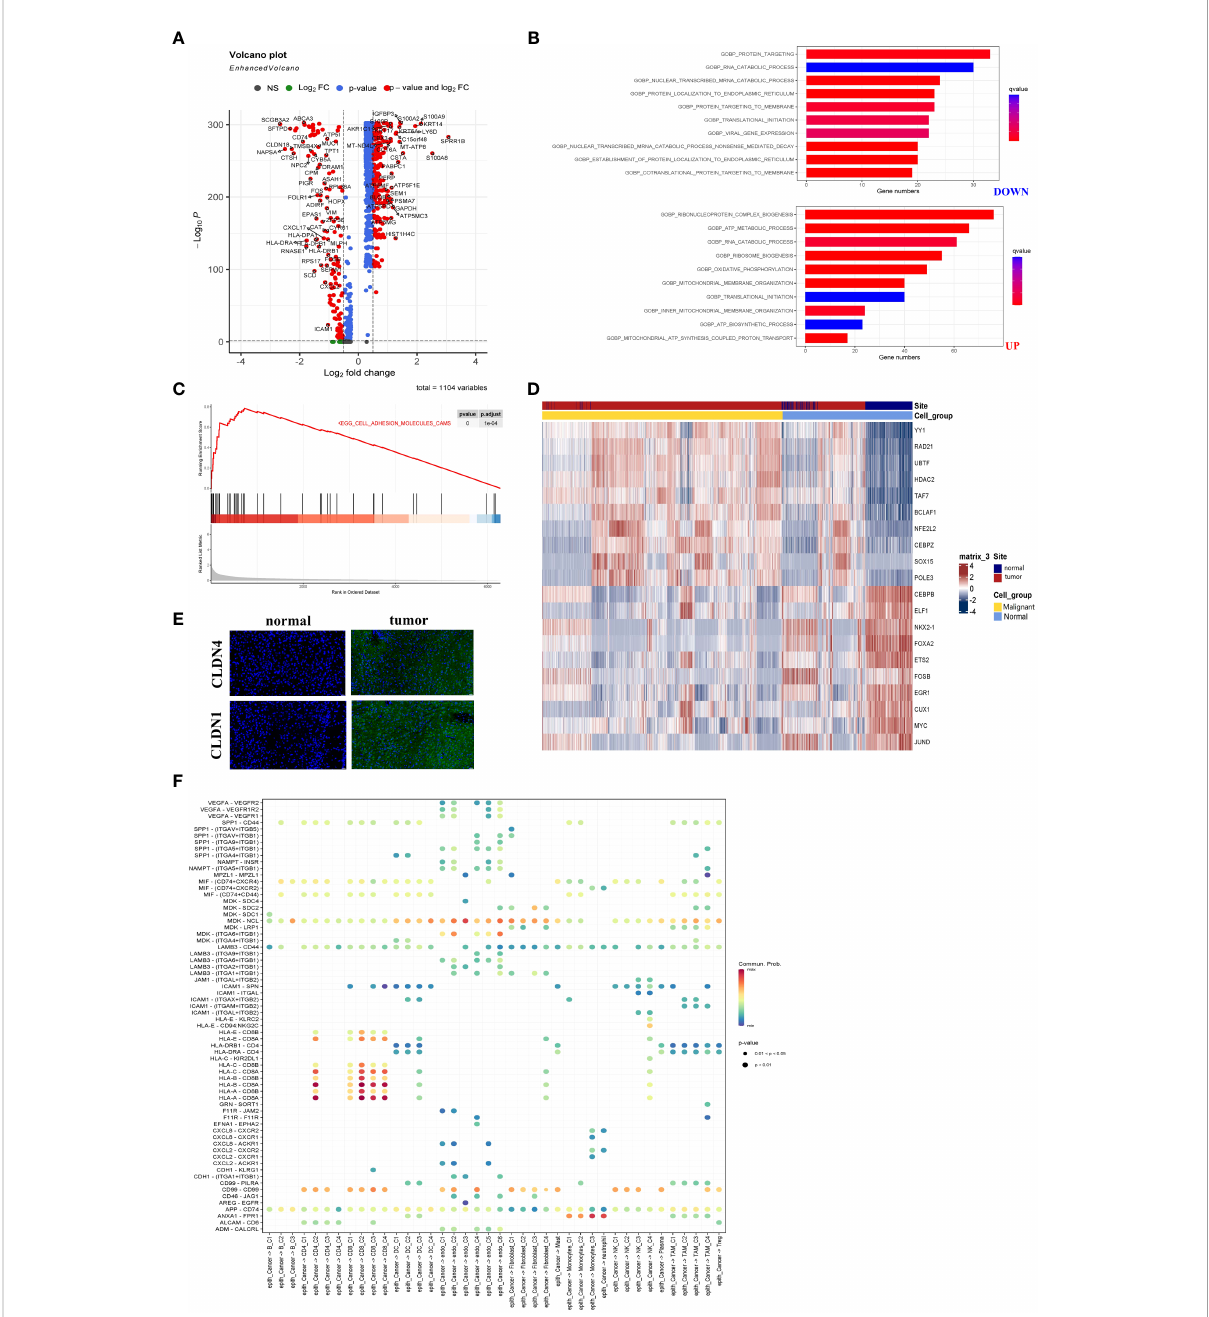
FIGURE 4 The metabolic abnormality was a speci fi c characteristic of LUAD. (A) Volcano plot showed DEGs between malignant and non-malignant epithelium. Upregulated and downregulated genes (FC >2 and FDR <0.01) were colored in red. (B) Analyzed upregulated and downregulated DEGs using Gene Ontology. The brighter red color was considered a smaller FDR value (FDR <0.01). (C) The malignant epithelium was signi fi cantly enriched in the ADHESION pathway by GSEA. (D) Immuno fl uorescence staining of CLDN1 and CLDN4 in LUAD or normal tissue. CLDN1 and CLDN4 only emerged in LUAD tissues. The scale bar represented 20 µm. (E) The heatmap showed the transcription factors ’ activity through SCENIC estimated AUC scores. The value was implicated into a row Z score. (F) The bubble plot showed selected ligand-receptor pairs. The CellChat R package investigated ligand-receptor interactions between malignant cells and other TME-in fi ltrated cell clusters.